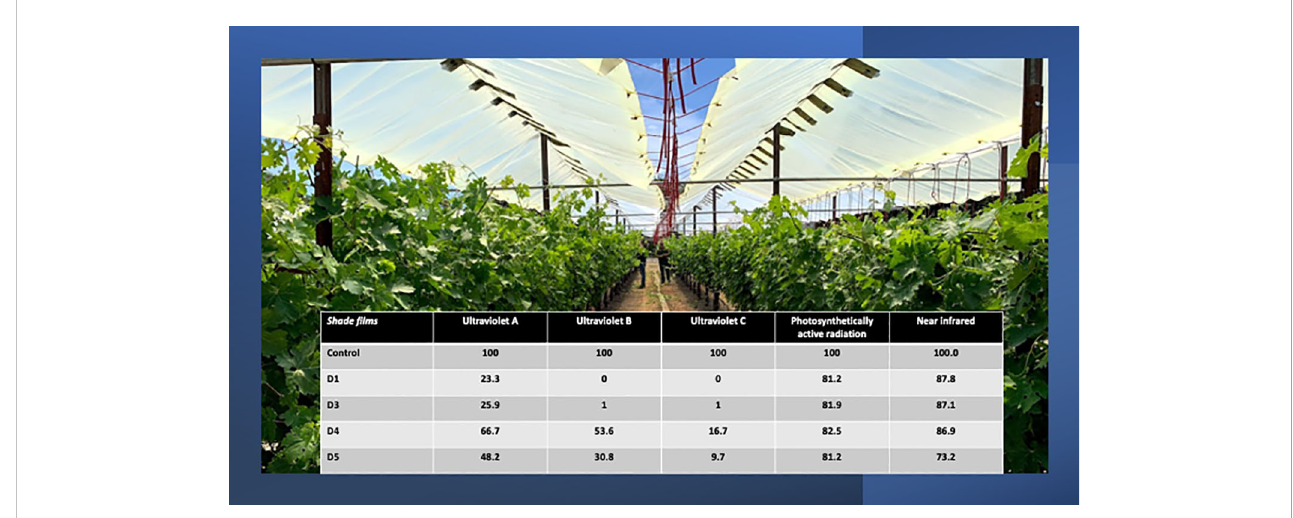
FIGURE 1 Overhead shade fi lms installed above the experimental vineyard and the percentage of solar radiation spectra transmitted through them at solar noon. Portion of this fi gure previously appeared in Marigliano et al.